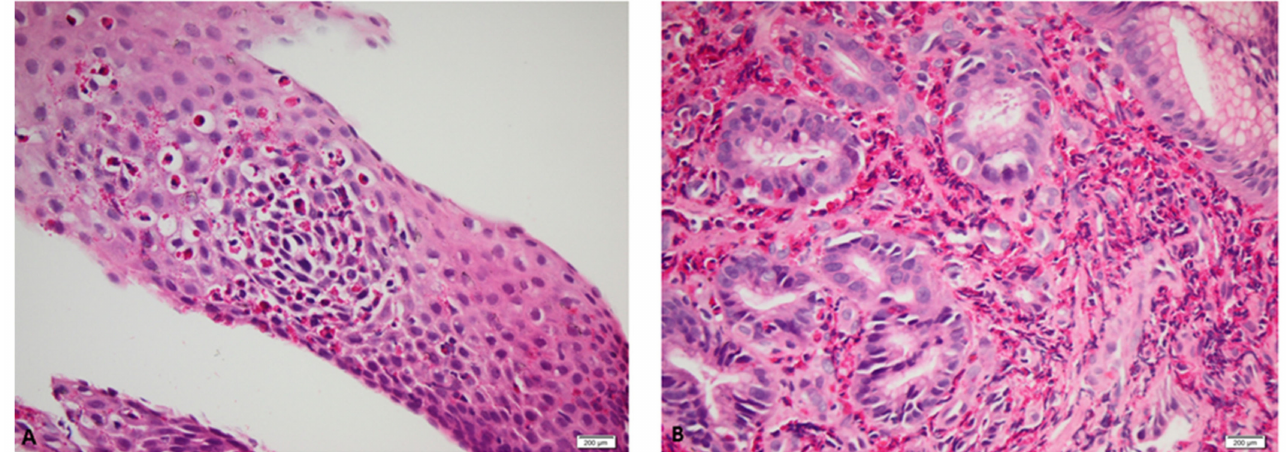
Figure 2. Histopathologic aspects of the oesophageal and gastric mucosa (Pathology Laboratory from Colentina Clinical Hospital). ( A ) Oesophageal mucosa with erosive areas, presenting acanthosis, areas of spongiosis and marked intraepithelial eosinophilic exocytosis with intraepithelial eosinophilic abscesses (96 Eos/HPF); ( B ) Multiple fragments of gastric antral mucosa showed florid infiltration by eosinophils (>200 Eos/HPF); the eosinophils are predominantly located within the lamina propria, with focal areas of involvement of the surface epithelium; there are florid reactive epithelial changes, with focal surface erosion and frequent glandular dilatations; no intestinal metaplasia, dysplasia or malignancy